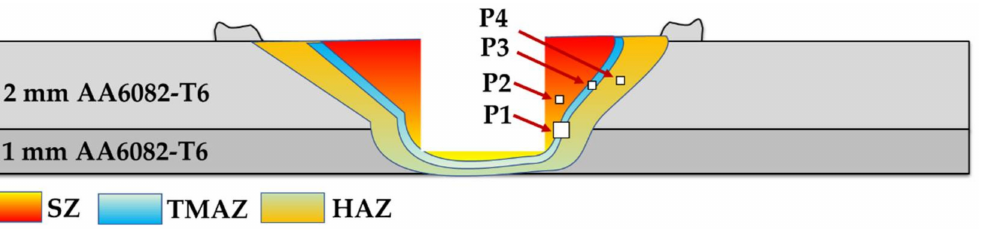
Figure 10. Schematic drawing showing the locations of the selected points (P1–P4) for the microstruc- ture examination of the friction spot weld